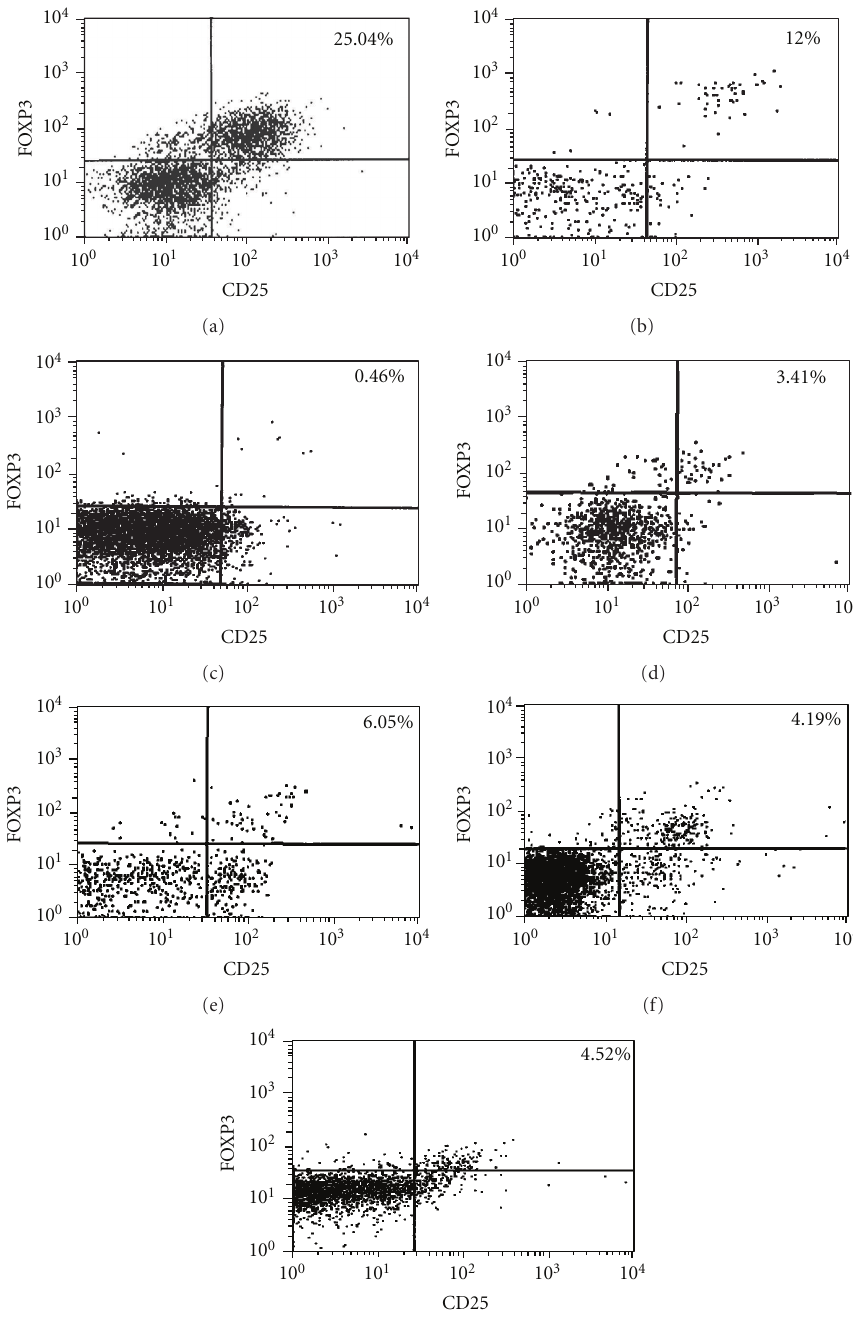
Figure 3: FOXP3 Treg cells in SCID patients. CD25 and FOXP3 expression levels in CD4 + T cells of pt1 (a), pt2 (b), pt3 (c), pt4 (d), pt5 (e), age-matched healthy control (f), and the mother of patient 1 (g) were detected using FACS analyses. Quadrants were set up based on staining with isotype control. Boxed numbers indicate the percentage of Treg cells within the CD4 +